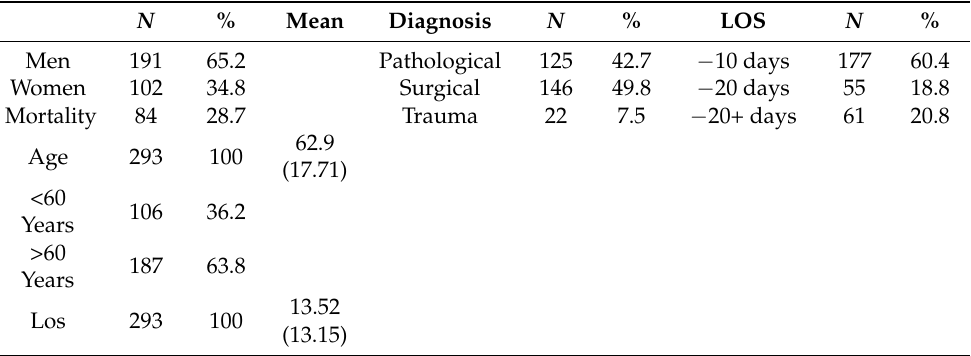
Table 3. Demographic characteristics of patients and diagnosis upon admission in intensive care units (ICU).